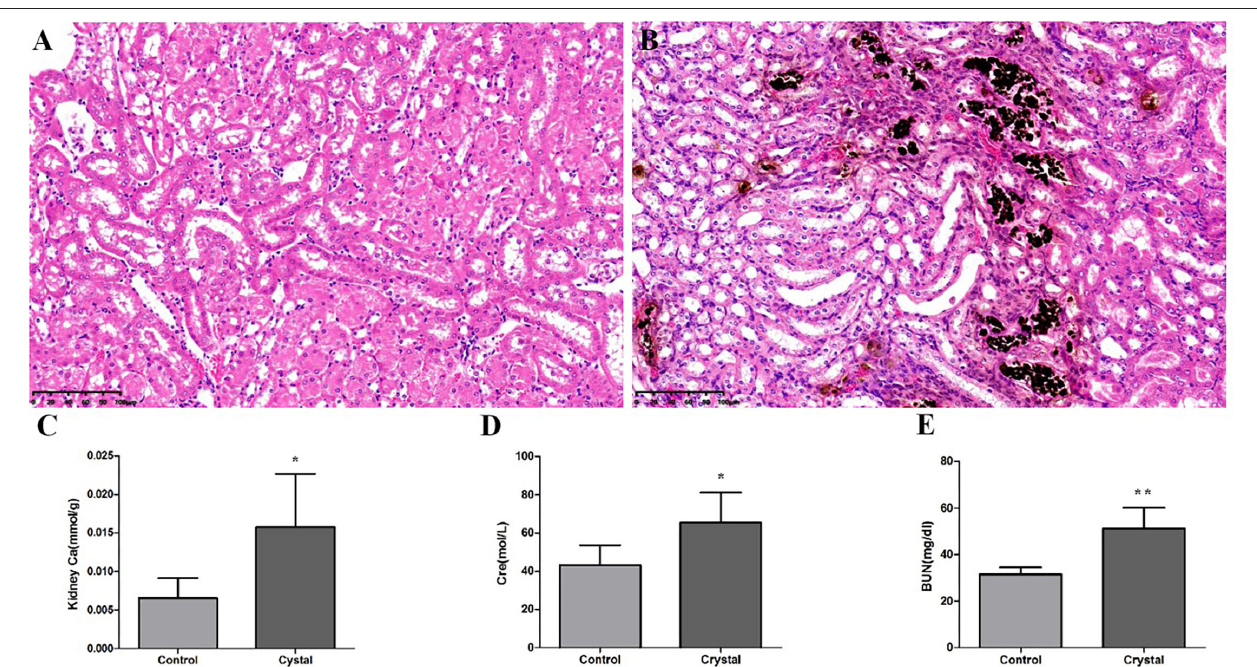
FIGURE 1 | The Von Kossa Staining sections ( × 400) ( n = 3) of kidney calcium and biochemical analyses ( n = 5) in the Control group and Crystal group. (A) Kidney slice stained with Von Kossa of the Control group, (B) Kidney slice stained with Von Kossa of the Crystal group, (C) Kidney calcium content of the Control group and Crystal group, and (D,E) the serum creatinine and blood nitrogen levels of the Control group and Crystal group. Data are expressed as mean ± SD, * p < 0.05 compared with the Control group, ** p < 0.01 compared with the Control